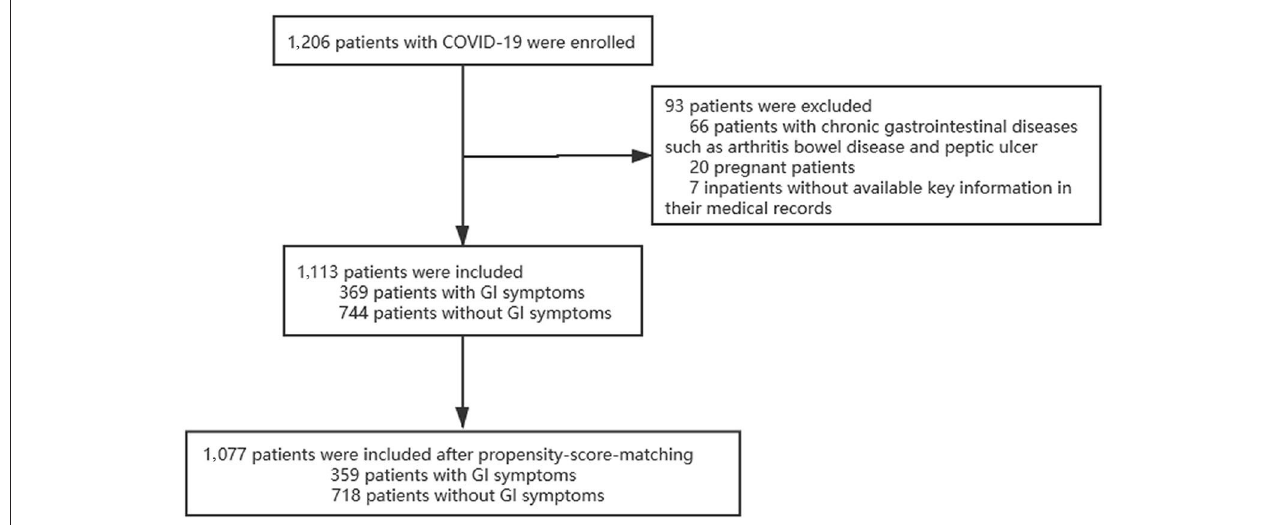
FIGURE 1 | Enrollment flowchart. GI, gastrointestinal injury.